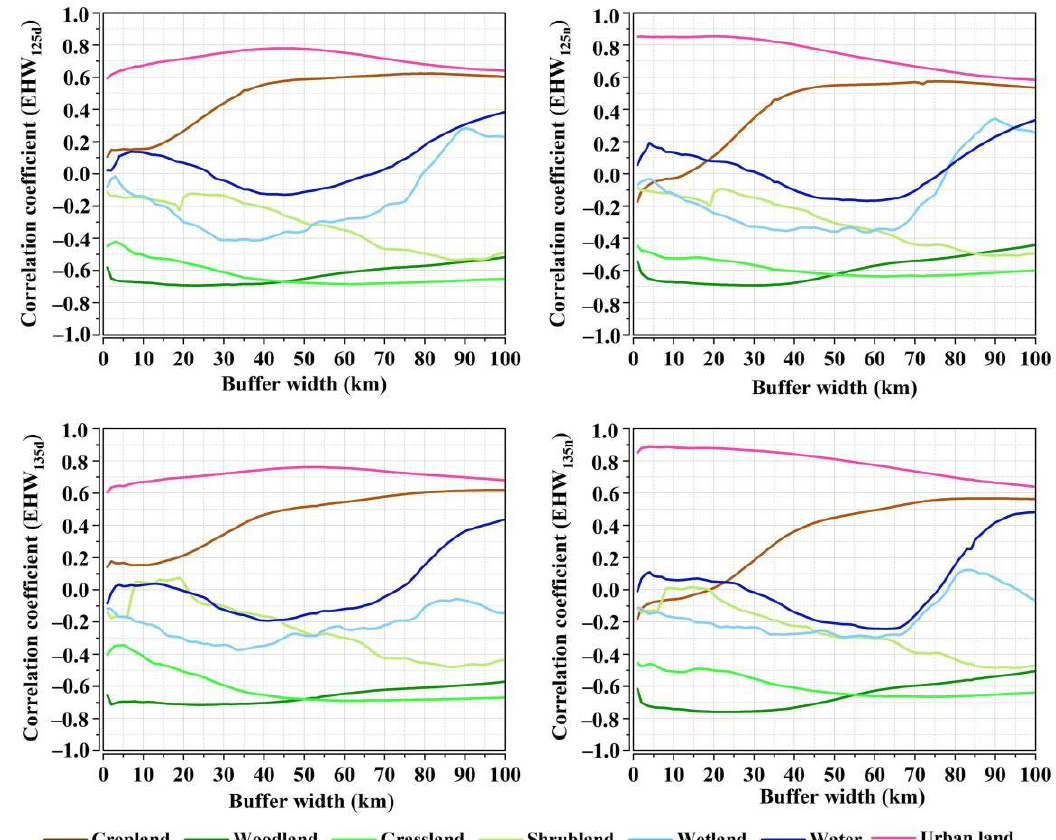
Figure 2. Correlation coefficients between the area of each land-use type in the 1 – 100 km buffer zones of the 225 MSs with EHW 125d , EHW 125n , EHW 135d , and EHW 135n . (EHW 125d represents the cu- mulative hours of daytime extreme heat waves during the 12th Five-Year Plan period, EHW 125n rep- resents the cumulative hours of nighttime extreme heat waves during the 12th Five-Year Plan period, EHW 135d represents the cumulative hours of daytime extreme heat waves during the 13th Five-Year Plan period, and EHW 135n represents the cumulative hours of nighttime extreme heat waves during the 13th Five-Year Plan period).